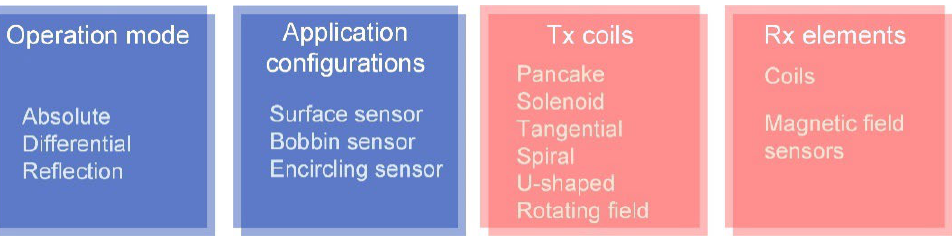
Figure 13. Calibration with a current sensing transformer.